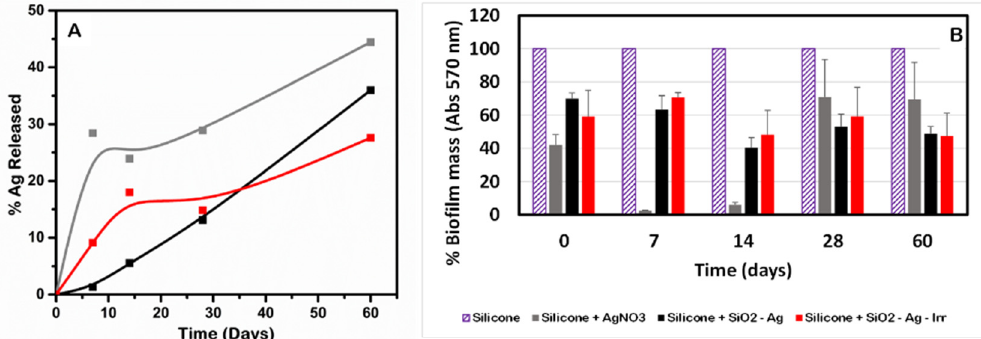
Figure 4. ( A ) Silver release from silicone functionalized with AgNO 3 (grey line), SiO 2 -Ag (black line) and SiO 2 -Ag-Irr (red line) in function of time. ( B ) Biofilm mass growth of A. niger in presence of silicone discs (purple striped columns) and functionalized silicone with AgNO 3 (grey columns), SiO 2 -Ag (black columns) and SiO 2 -Ag-irr (red columns).